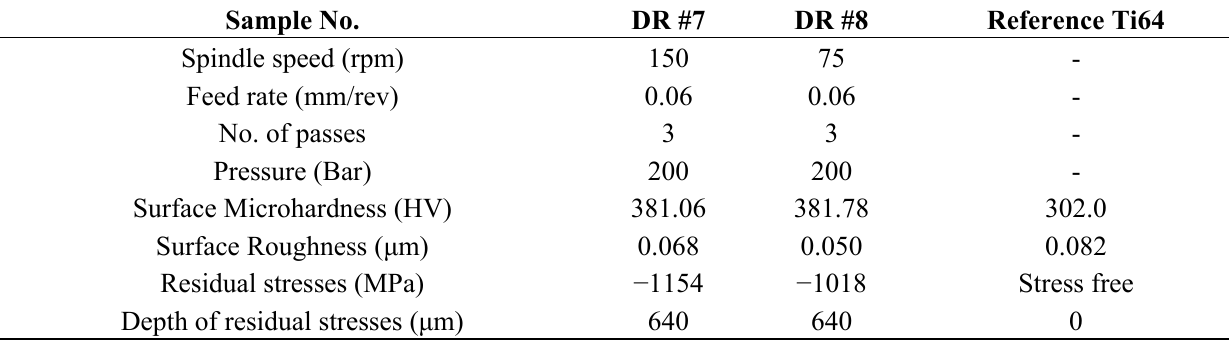
Table 3. Summary of the DR processing parameters and experimental results of samples DR # 7 and 8 and reference